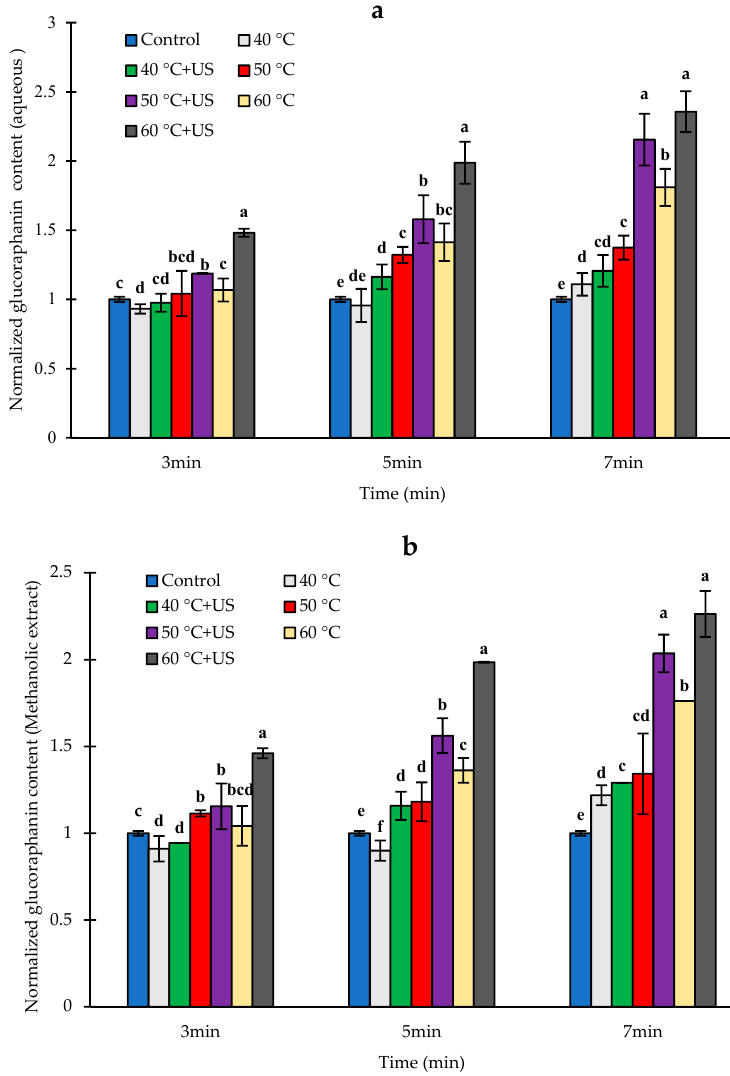
Figure 4. The normalized residual level of glucoraphanin contents (glucoraphanin content in treated samples/glucoraphanin content in untreated control) in aqueous ( a ) and methanolic ( b ) extracts from broccoli puree after thermal/thermosonication pre-treatments of broccoli florets and conversion to sulforaphane. Letters above each bar indicate the results of Duncan’s test; Different letters within the same group indicate significant difference ( p < 0.05).